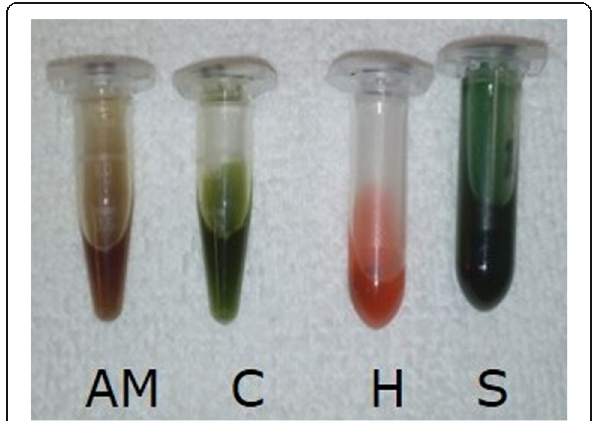
Fig. 1 Colour of desalted extracts after mechanical disruption. Note that the colour of the AM extract changed from green to brown due to the orange-red colour of the dye present in the IPEC-J2 culture medium used for desalting